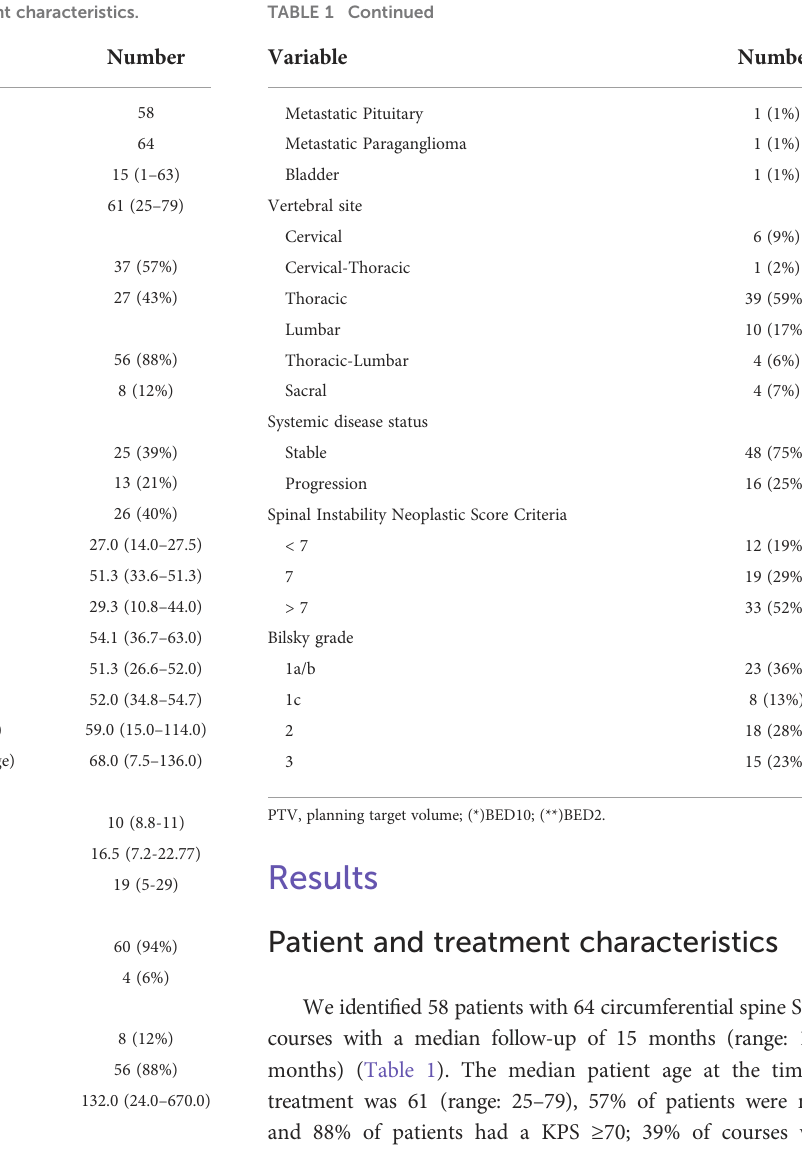
TABLE 1 Patient demographic and treatment